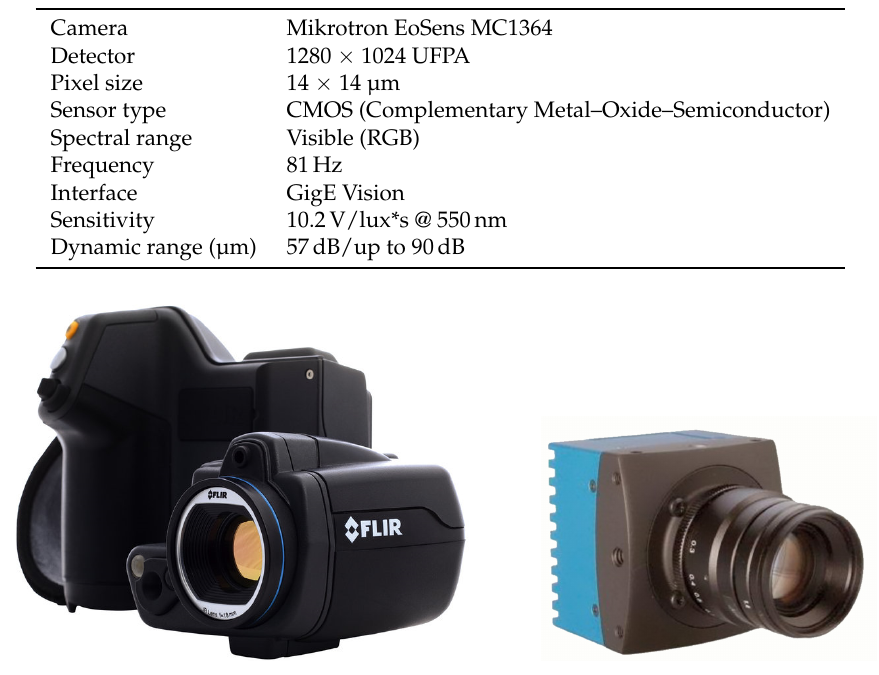
Technical specifications of the visible camera Mikrotron EoSens MC1364 used in the experiments.